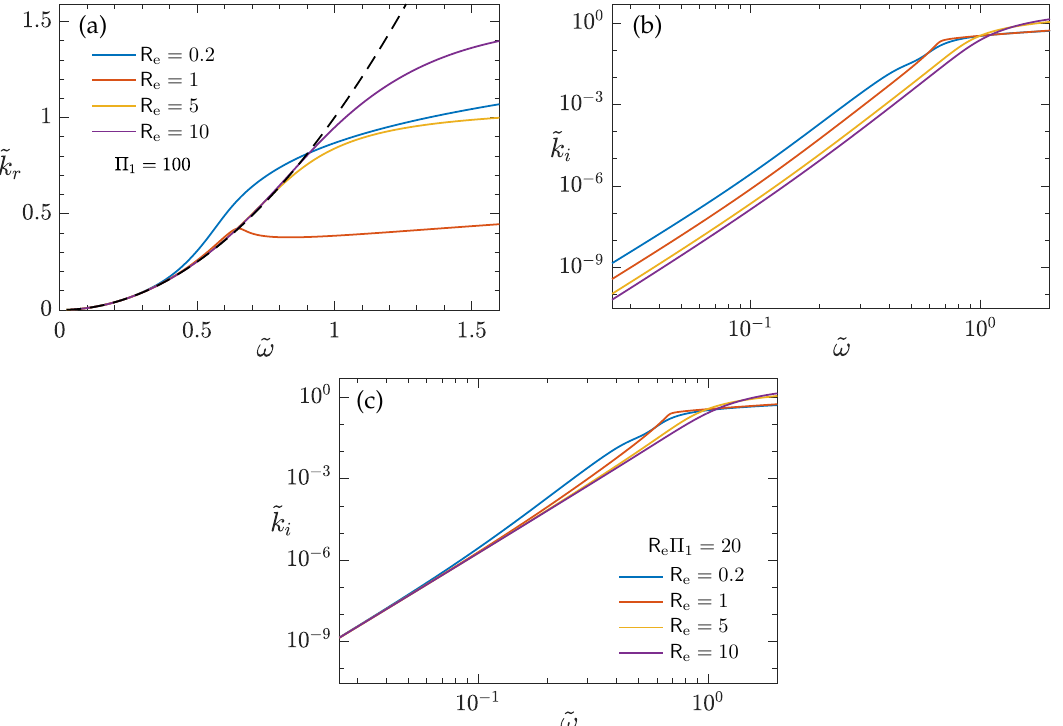
Figure 3. ( a ) ˜ k r ( ˜ ω ) , ( b ) ˜ k i ( ˜ ω ) with Π 1 = 100 and varying R e . In ( a ), Lamb’s solution for inviscid fluids is included as a reference (dashed black). ( c ) ˜ k i ( ˜ ω ) , showing the effect of ice viscosity by varying R e and keeping R e Π 1 constant (see text for